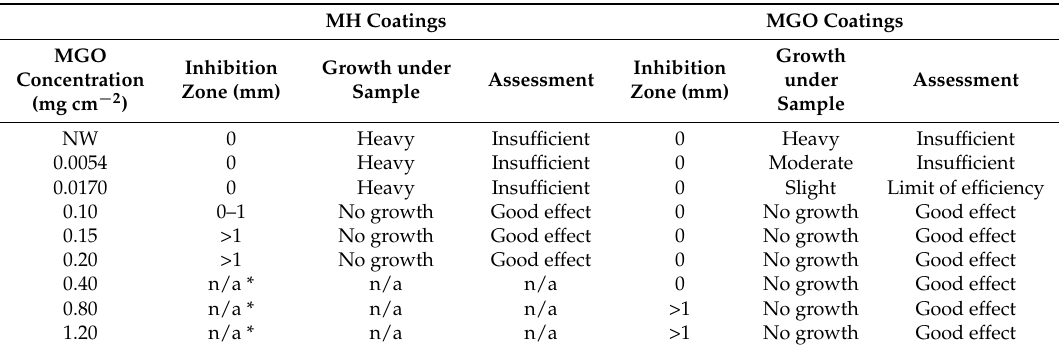
Table 5. Effect of MGO concentration on the growth of S. aureus when applied as a physical coating onto nonwoven samples.